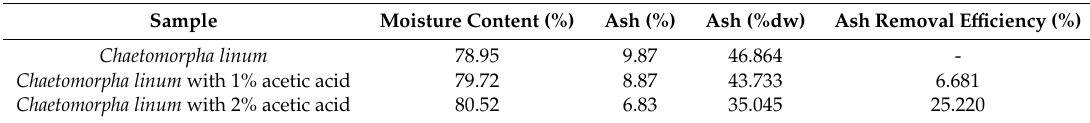
Table 5. The results of demineralization through acetic-acid